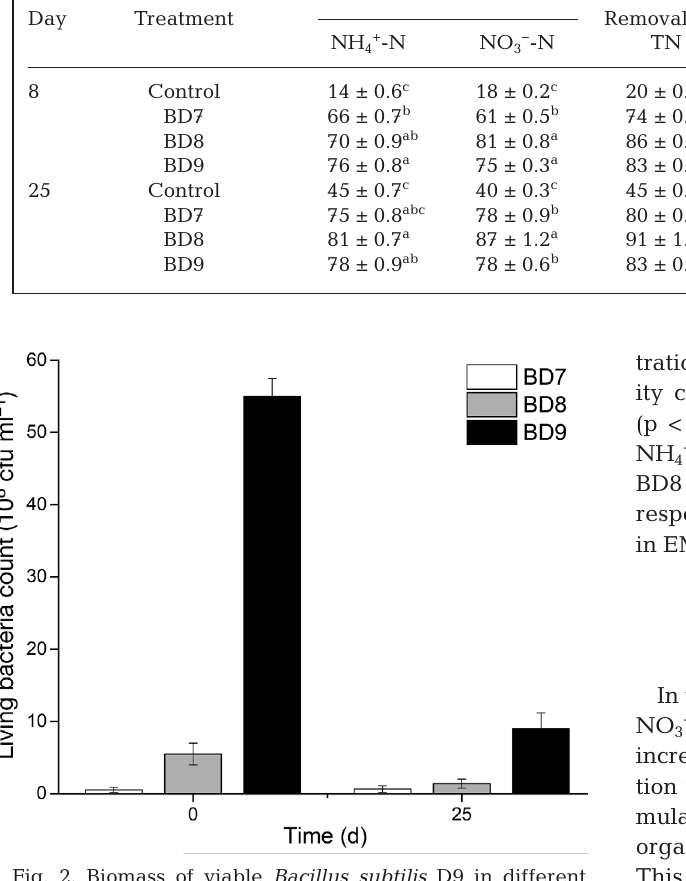
Fig. 2. Biomass of viable Bacillus subtilis D9 in different treatments on Days 0 and 25. Vertical bars represent ±SD of the means (n = 3). BD7/BD8/BD9: inoculation levels of Bacil- lus subtilis D9 at 5.5 × 10 7 / 5.5 × 10 8 / 5.5 × 10 9 cfu ml